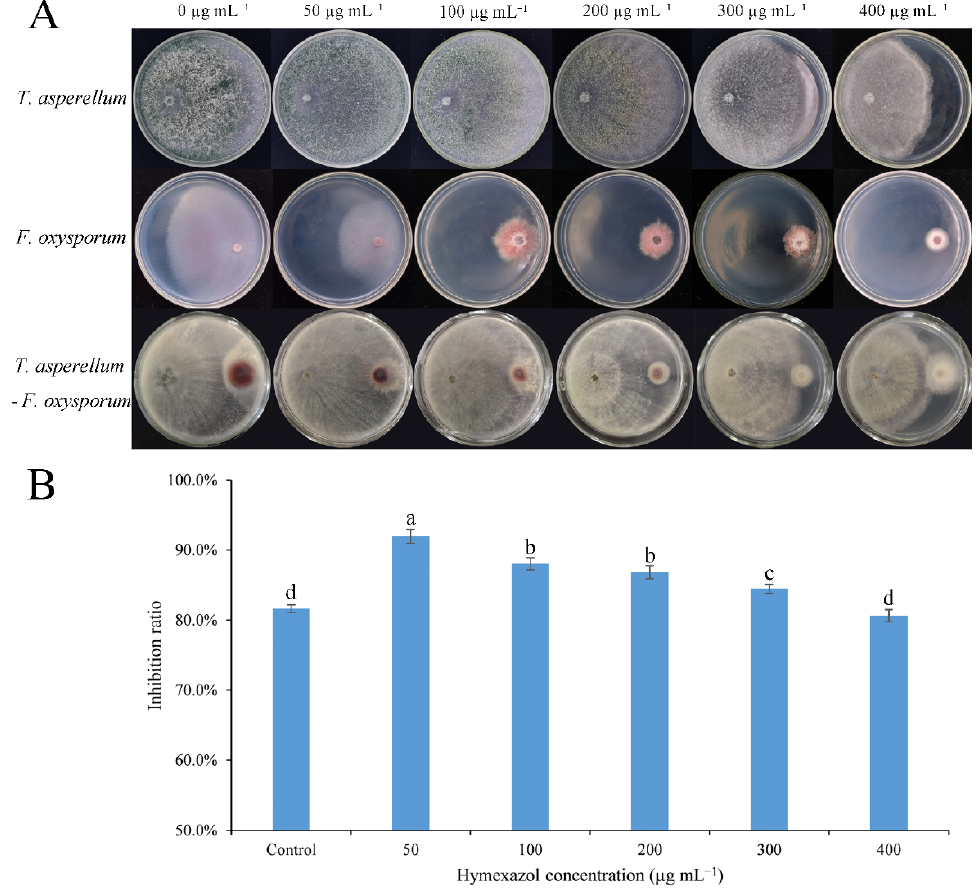
Figure 2. The antagonism effect of the combination of Trichoderma SC012 and hymexazol to F. oxysporum FC018. ( A ) Dual culture of T. asperellum SC012 and F. oxysporum FC018 at different concentrations of hymexazol; ( B ) inhibition rate of Trichoderma strain to F. oxysporum at different concentrations of hymexazol. Data presented are the means ± SE. The different lowercase letters indicate significant difference ( p < 0.05) among the treatments.